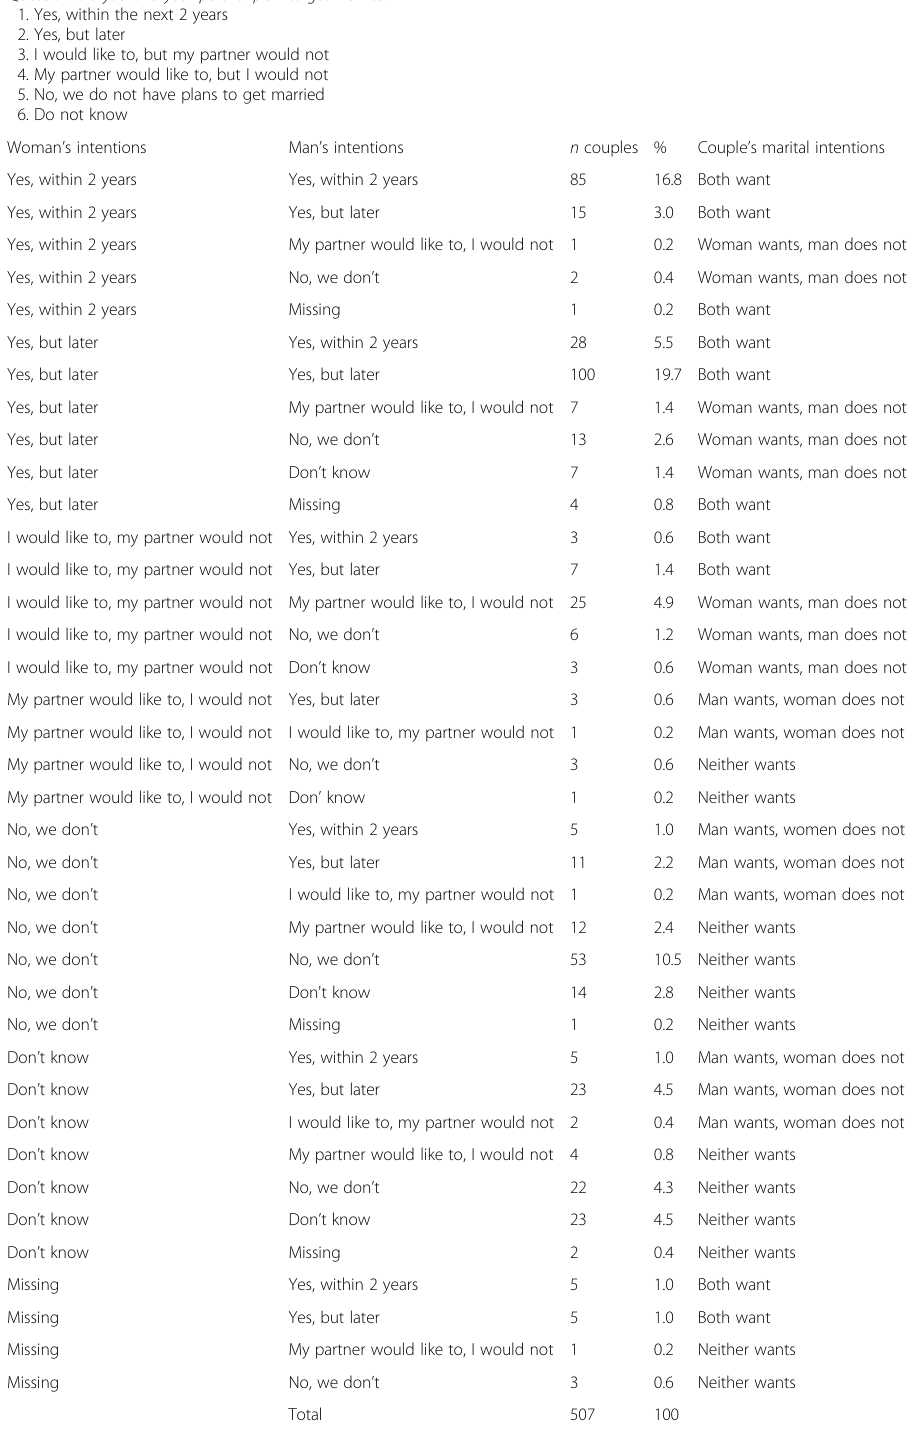
Table 5 Coding schema: Couples ’ marital intentions in